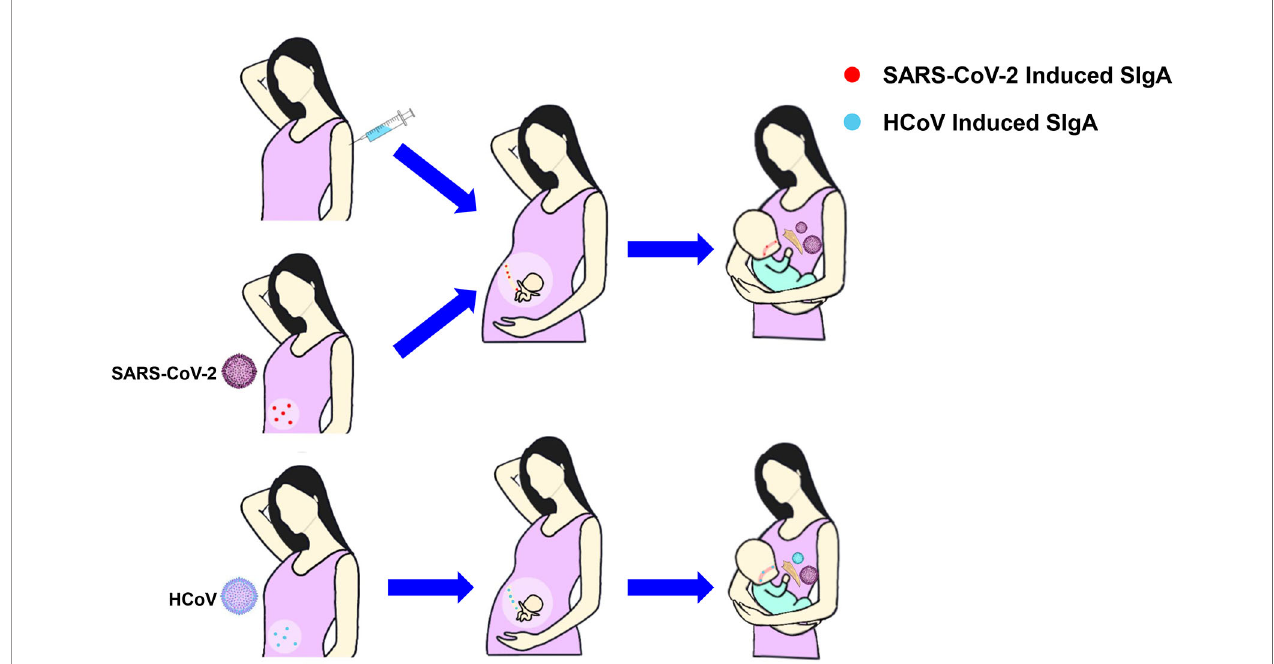
FIGURE 3 | The production and transfer of SIgA in breastmilk. Mothers infected with COVID-19 or vaccinated with COVID-19 have IgA antibodies in breastmilk that can be transferred to the fetuses through the placenta or to the infants through breastmilk, protecting them from infection. SIgA induced by HCoV can